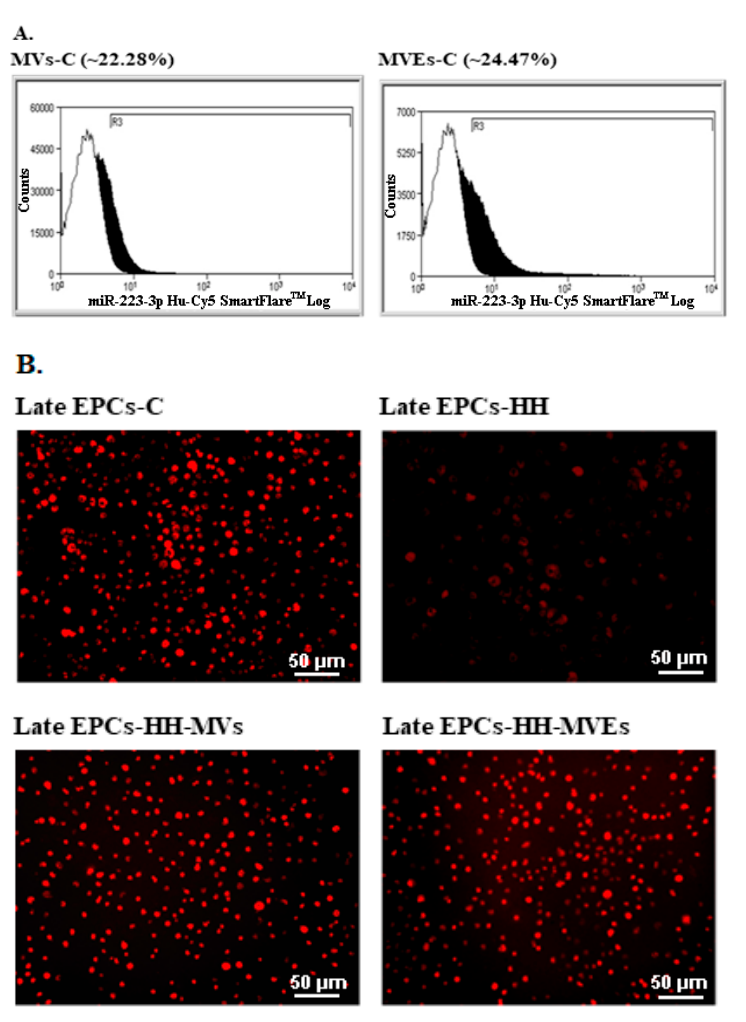
Figure 8. Evaluation of miR-223 expression by fluorescence detection using a miR-223-3p Hu-Cy5 SmartFlare ( n = 5 individual animals per group): ( A ). The analysis of miR-223 expression in circulating MVs and MVEs by flow cytometry detection; ( B ). The assessment of miR-223 expression in late EPC cultures from the C, H, HH-MVs, and HH-MVEs animal groups by fluorescence microscopy.